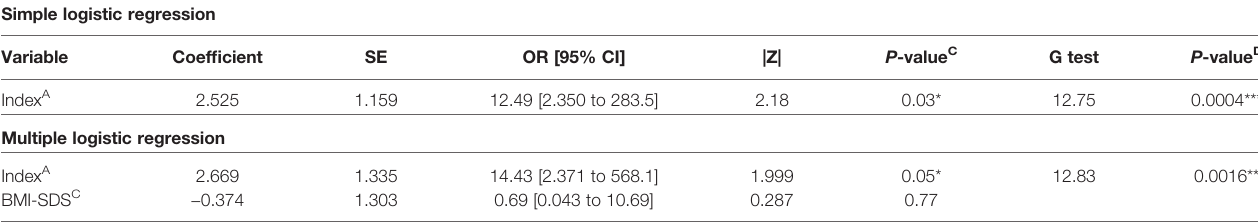
TABLE 4 | Simple logistic regression of index as a determinant of PR in pediatric patients at T1D onset and its adjustment for BMI-SDS. Simple logistic regression